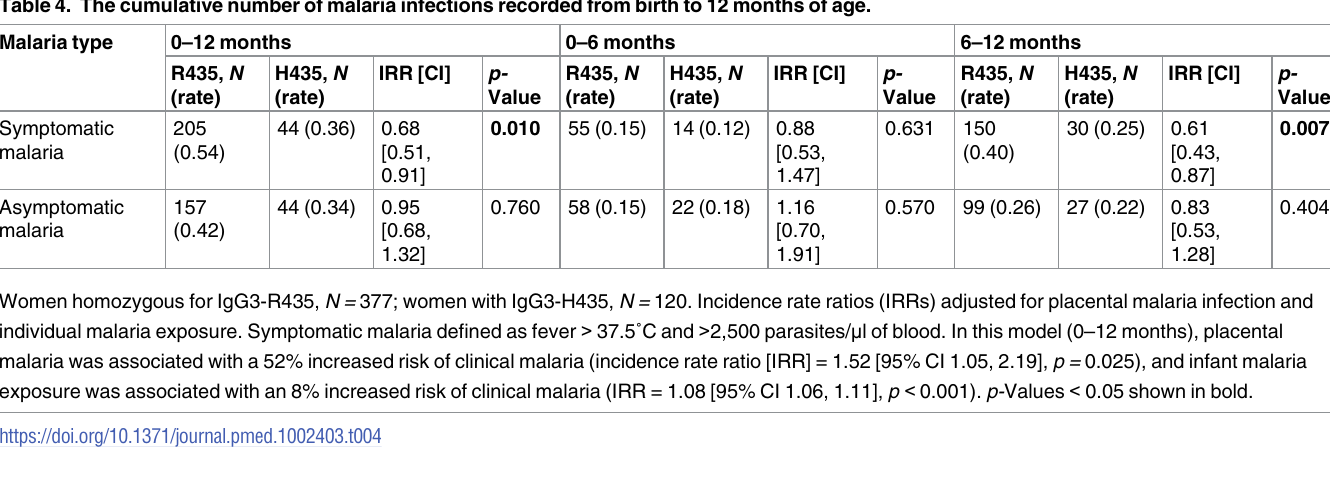
expands the observation that IgG3-H435 alters the biological characteristics of IgG3 by enhancing its transplacental transfer and prolonging its half-life in vivo. Offspring of women with IgG3-H435 had a 31% to 39% reduced risk of clinical malaria during infancy based on 2 independent analytic models. There was no association with protec- tion against asymptomatic malaria, suggesting that the association was not related to exposure, but to the ability to control the level of parasitemia. This association was most pronounced at 6 to 8 months of age, when most of the passively transferred antibody protection in an infant has typically waned. There are several possible explanations for a delayed protective effect. First,